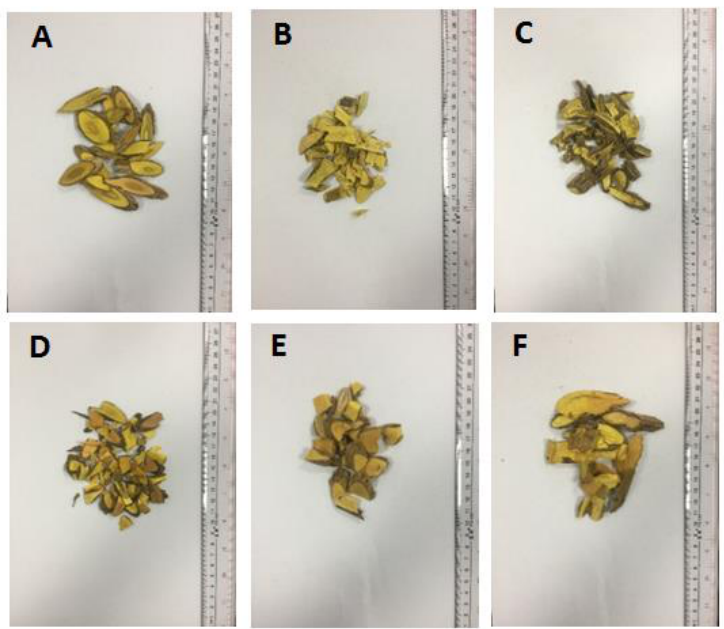
Figure 1. Appearance characters of M. bealei samples and its substitutes. A : cultivated M. bealei ; B :